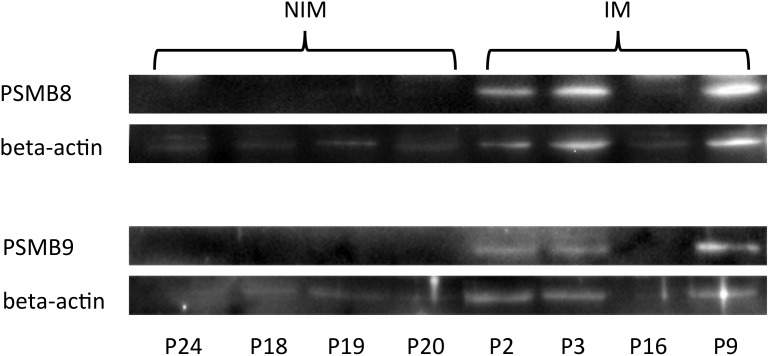
Protein expression of the immunoproteasome subunits PSMB8 and PSMB9 relative to beta actin in IM and NIM.The protein expression of the two subunits was analyzed by western blot in muscle biopsies from four non-inflammatory myopathies (NIM) and four inflammatory myopathies (IM). Intensity of chemiluminescent signals for PSMB8 and PSMB9 was normalized to corresponding signals of the housekeeping protein beta actin, which was detected in a second staining procedure on the same membrane. Only IM samples revealed PSMB8 and -9 protein expression.